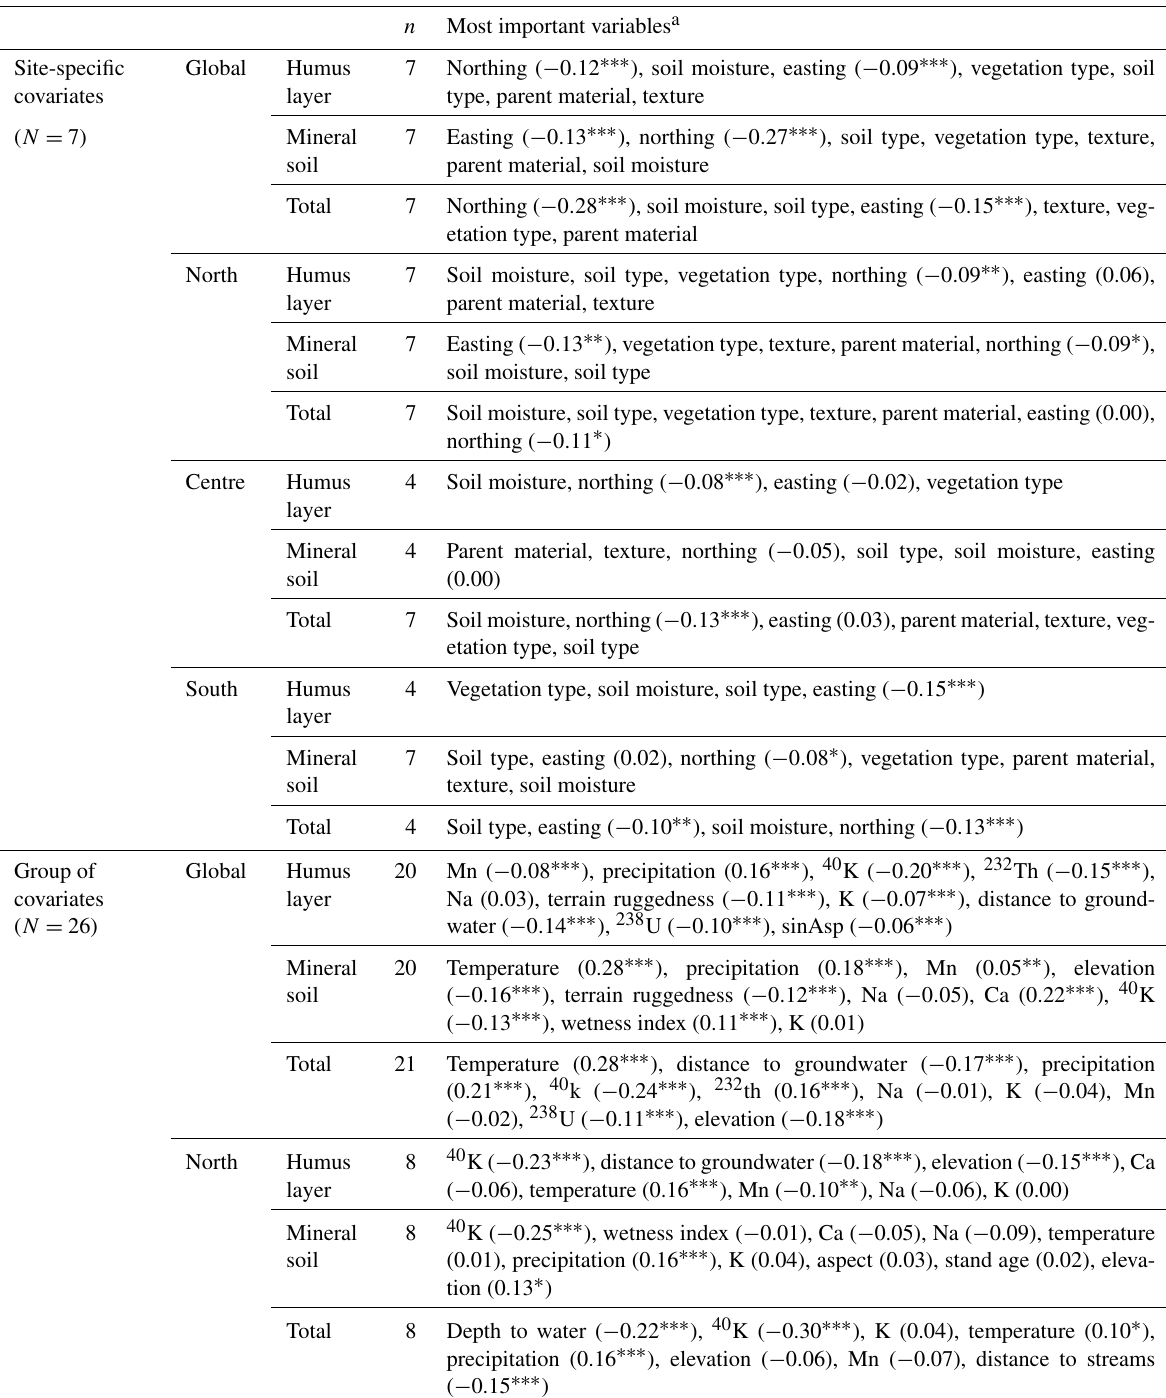
Table 5. Random forest variable importance for the global and local models for the humus layer, mineral soil, and total SOC stock with their associated Pearson’s coefficient of correlation with the covariates (values in parenthesis are as follows: ∗ p ≤ 0 . 05; ∗∗ p ≤ 0 . 01; ∗∗∗ p ≤ 0 .